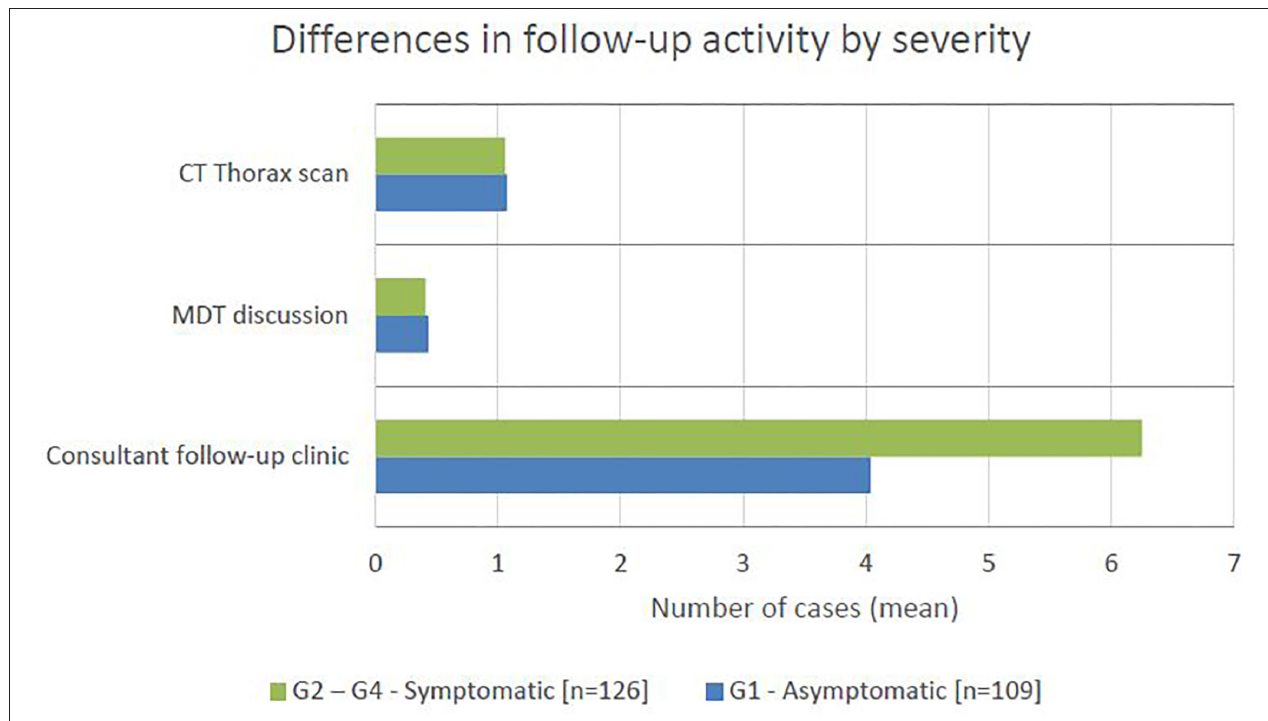
FIGURE 4 | The mean number of cases requiring CT thorax scan, MDT discussion, and consultant follow-up clinic appointment in the 16 weeks following pneumonitis diagnosis, by severity.